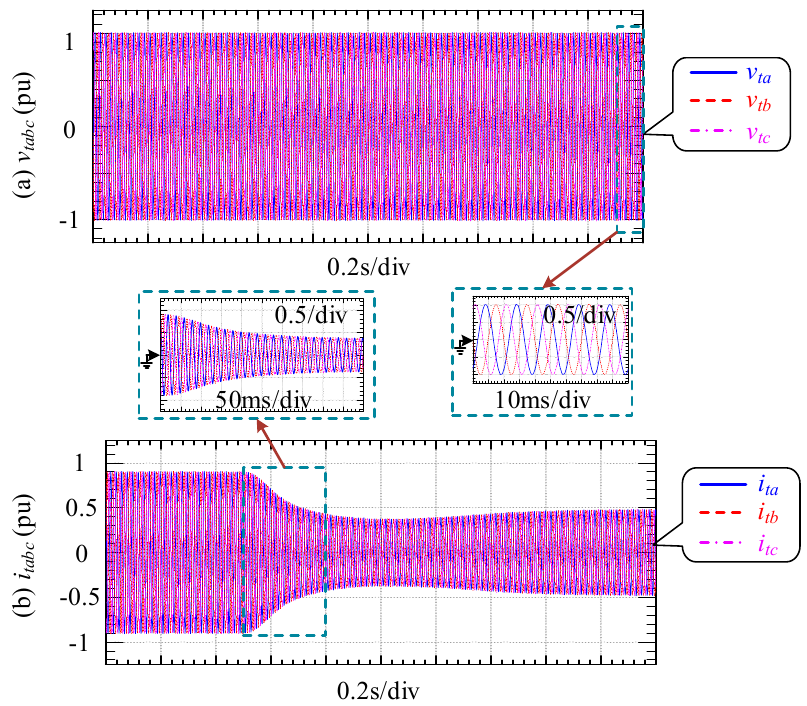
Figure 13. Wind speed step change at t = 0.5 s.